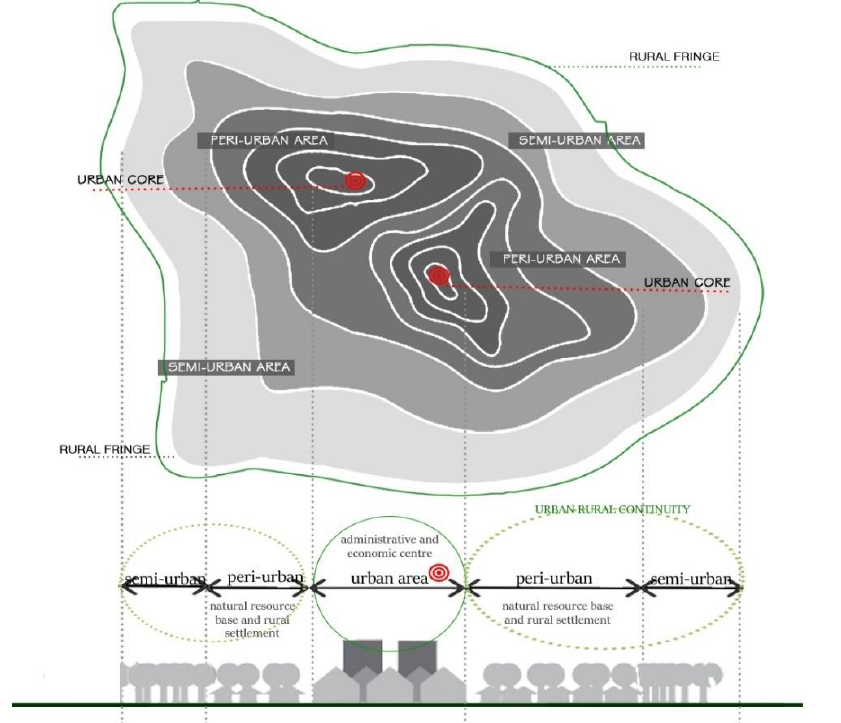
Figure 1: Diagram illustrating placement of urban, peri-urban, semi urban and rural areas. Source